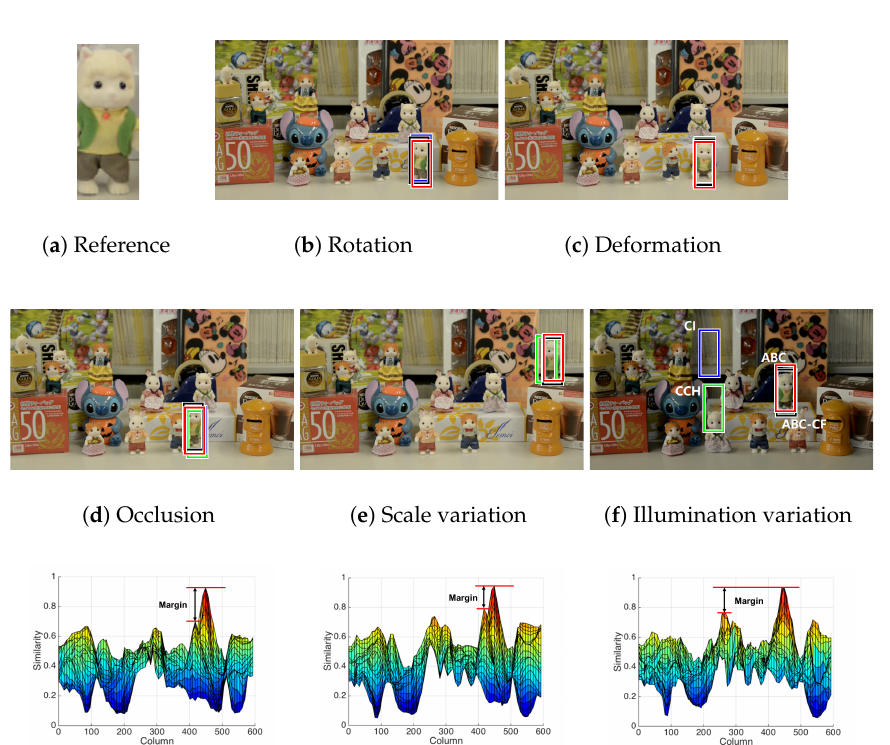
Figure 10. Matched results in ( a ) reference image. ( b – f ) show matching results by CI, CCH, ABC, and ABC-CF. Bounding black, red, blue, and green boxes show matching results by ABC-CF, ABC, CI, and CCH, respectively. ( g – i ) show profiles of their similarity in the case of rotation. Figure 11 shows the results of ABC and ABC-CF.